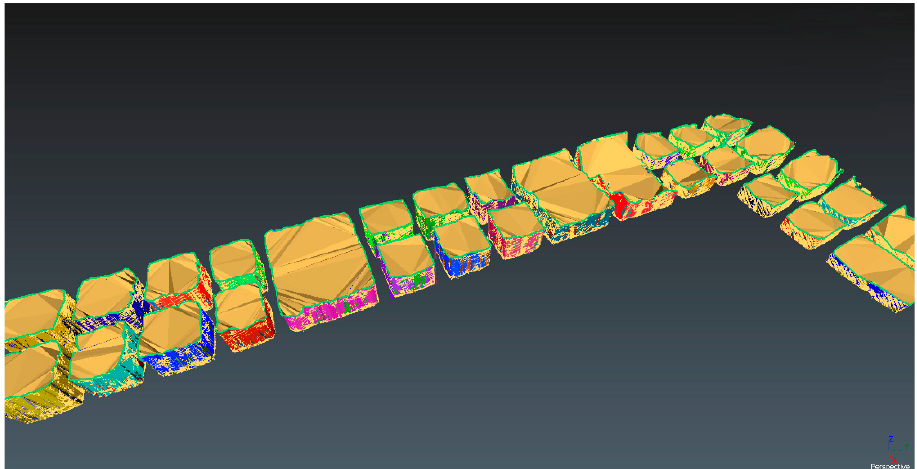
Figure 12. Modelling for the calculation of lacus volumes.